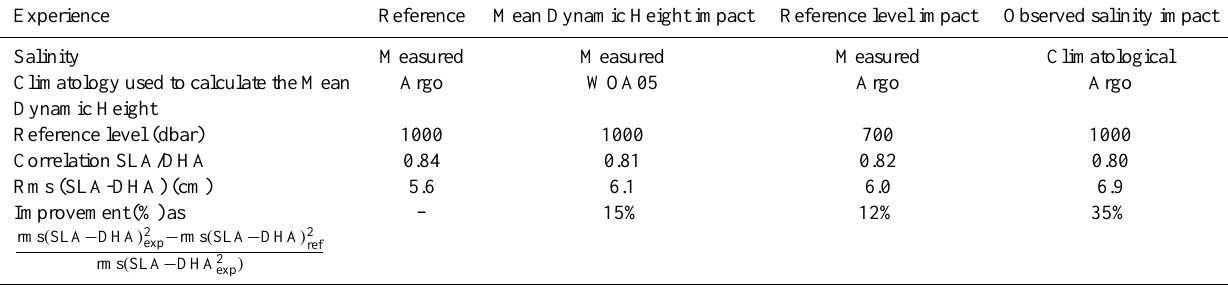
Table 1. Correlation and rms difference between SLA and DHA for different experiences. Statistics have been calculated using a data set of 325000